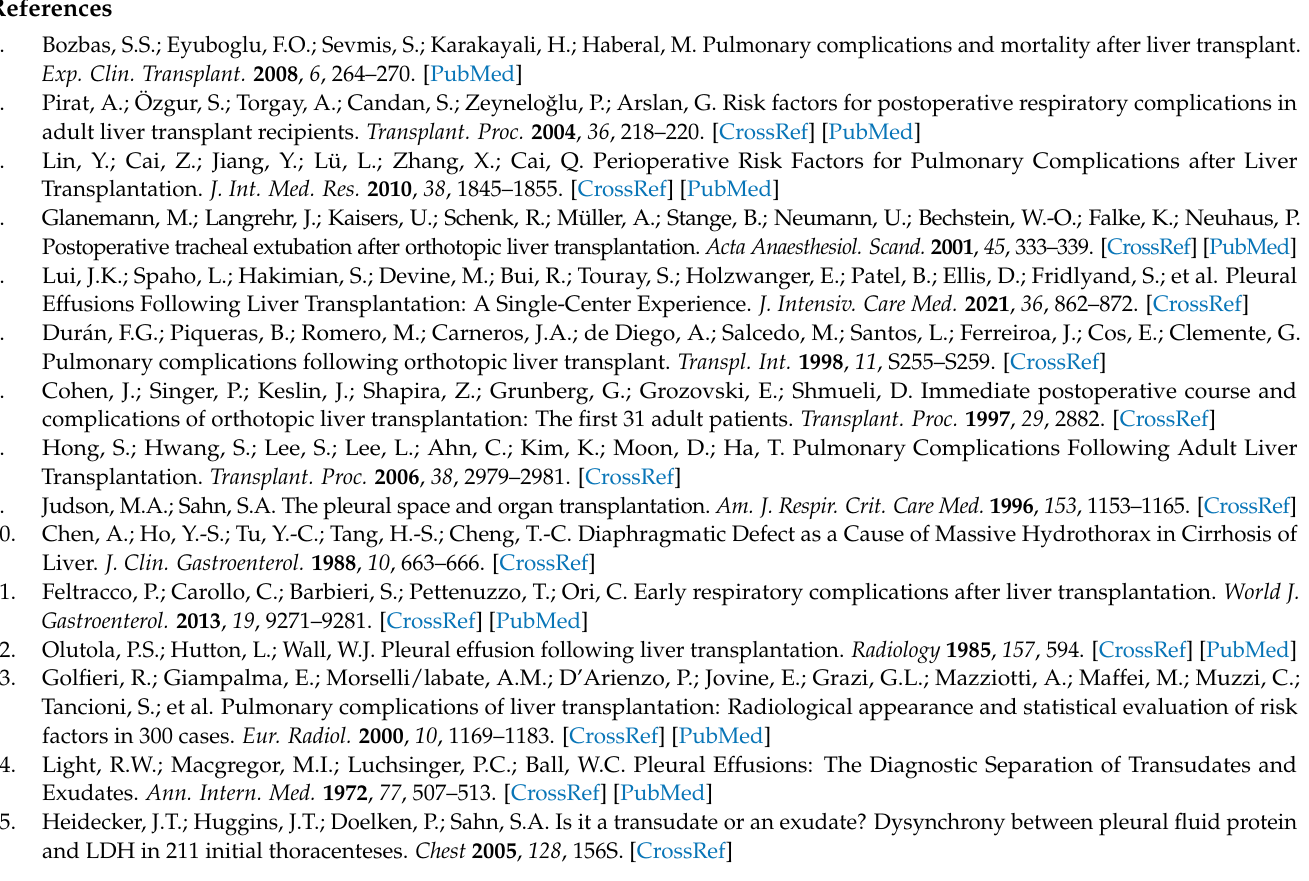
Abbreviations: LDH, lactate dehydrogenase; MELD, Model for End-Stage Live Disease; PF, pleural fluid; PPEf, persistent pleural effusion; a = mean ± SD. b = n